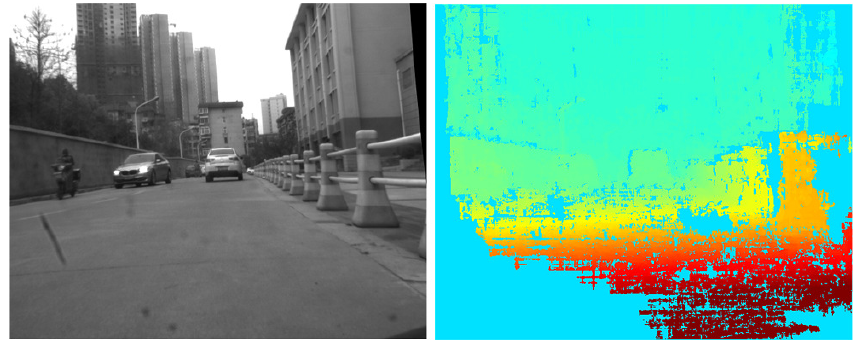
Figure 2. Left: The rectified left image. Right: The disparity map obtained by the SGM method. In the image segmentation, the gradient information computed by Roberts operators is used to supplement the segmentation energy function. Where gradient energy is: